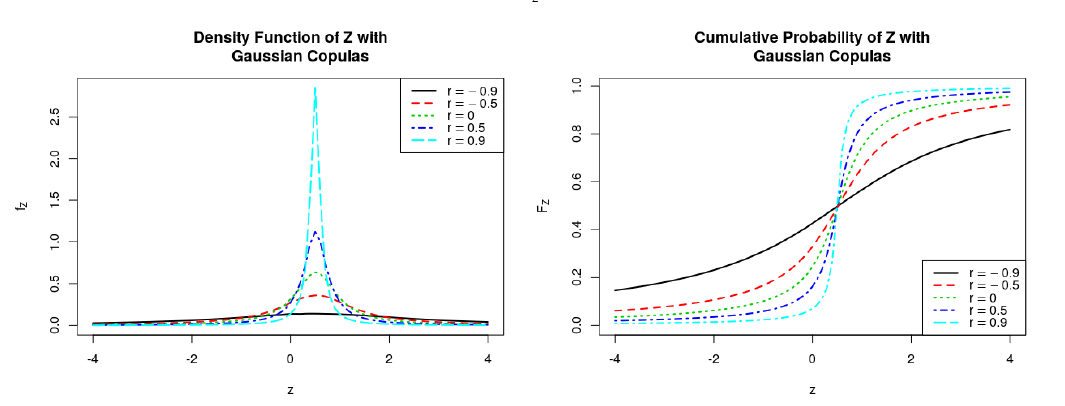
, where ( X 1 , X 2 ) follows Gaussian Copulas. X 2